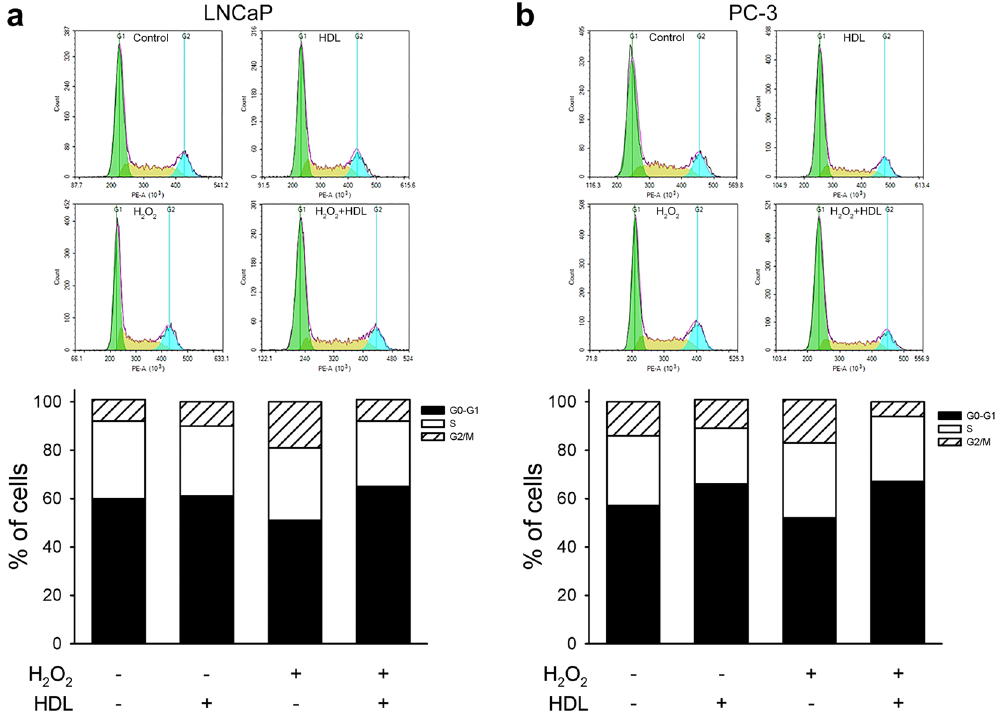
Figure 6. HDL modulate cell cycle distribution in H 2 O 2 -treated cells. LNCaP (Panel a) and PC-3 cells (Panel b) were incubated for 72 h with H 2 O 2 5 μ M, HDL 0.5 mg/ml or with a combination of both. Cells were then harvested, stained with propidium iodide and subjected to FACS analysis. Representative histograms of each experimental group and cumulative results of the percentage distribution along cell cycle (n = 3) are